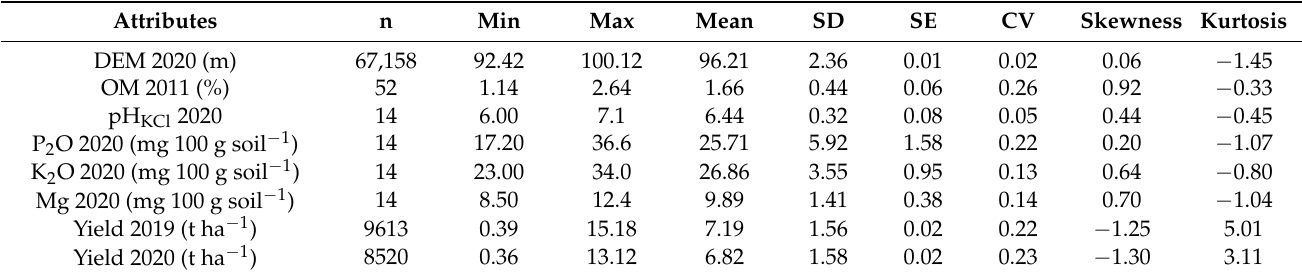
Table 3. Descriptive statistics of DEM, soil attributes and wheat yield.